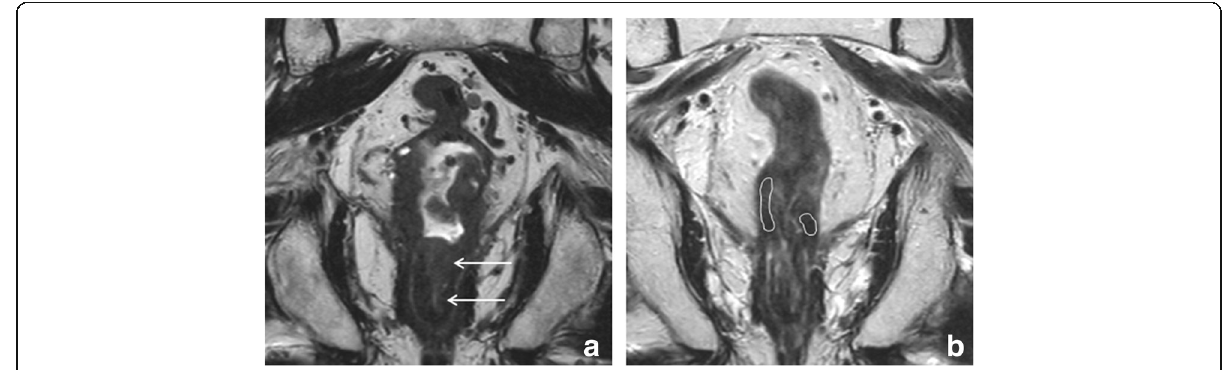
Fig. 3 Assessment of sphincter involvement. Coronal T2-weighted MR images of a male patient with a tumor in the distal rectum before ( a ) and after CRT ( b ). Before treatment the tumor extends into the proximal one third of the anal canal where it invades the internal anal sphincter on the left lateral side (arrow in a ). After CRT, the tumor has decreased considerably in size and retracted from the anal canal. A fibrotic remnant (circles in b ) remains visible above the level of the anorectal junction. The anal sphincter is no longer involved